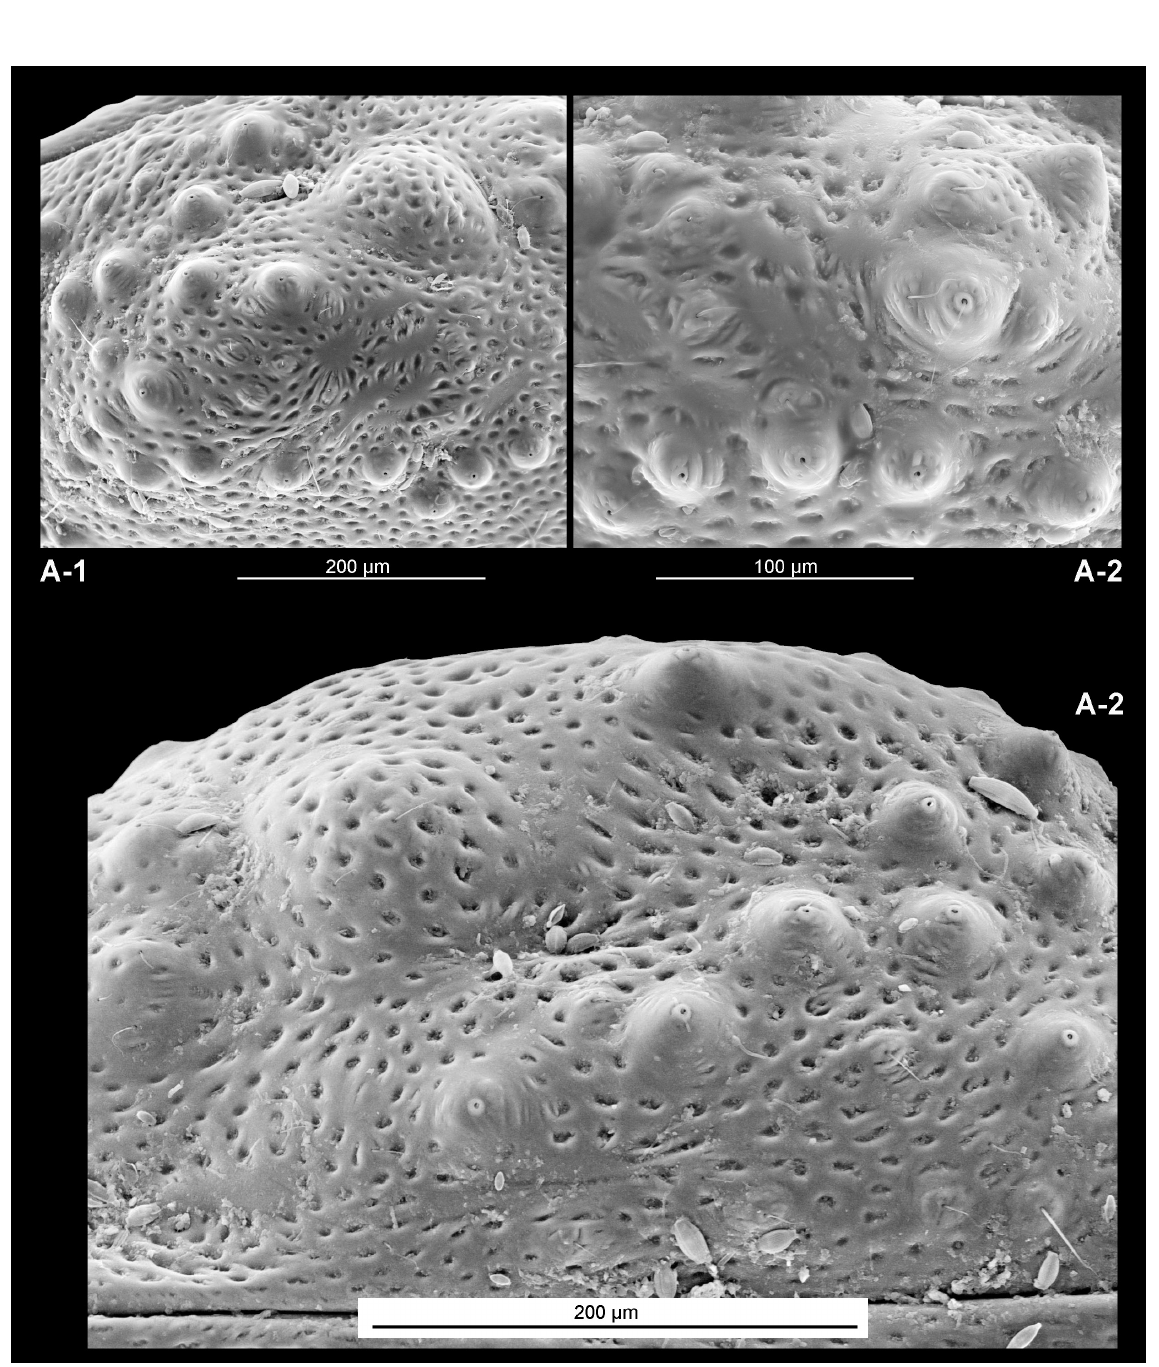
Fig. 5. Details of external lateral views of carapaces of Bennelongia cf. nimala nov. sp. juveniles from Muggon Lake. Top left . A-1 showing the dome and many of the cones with outer lips. Note the large pseudo-pores that are elongated over what appears to be a second protuberance. Top right . A-2 showing the cones with the outer lips at their apex. Many of the pores yield a seta. Bottom . RV of A-2 in dorsal view, showing the assemblage of cones with outer lips and the dome, on top of which a seta occurs. Note the hinge at the